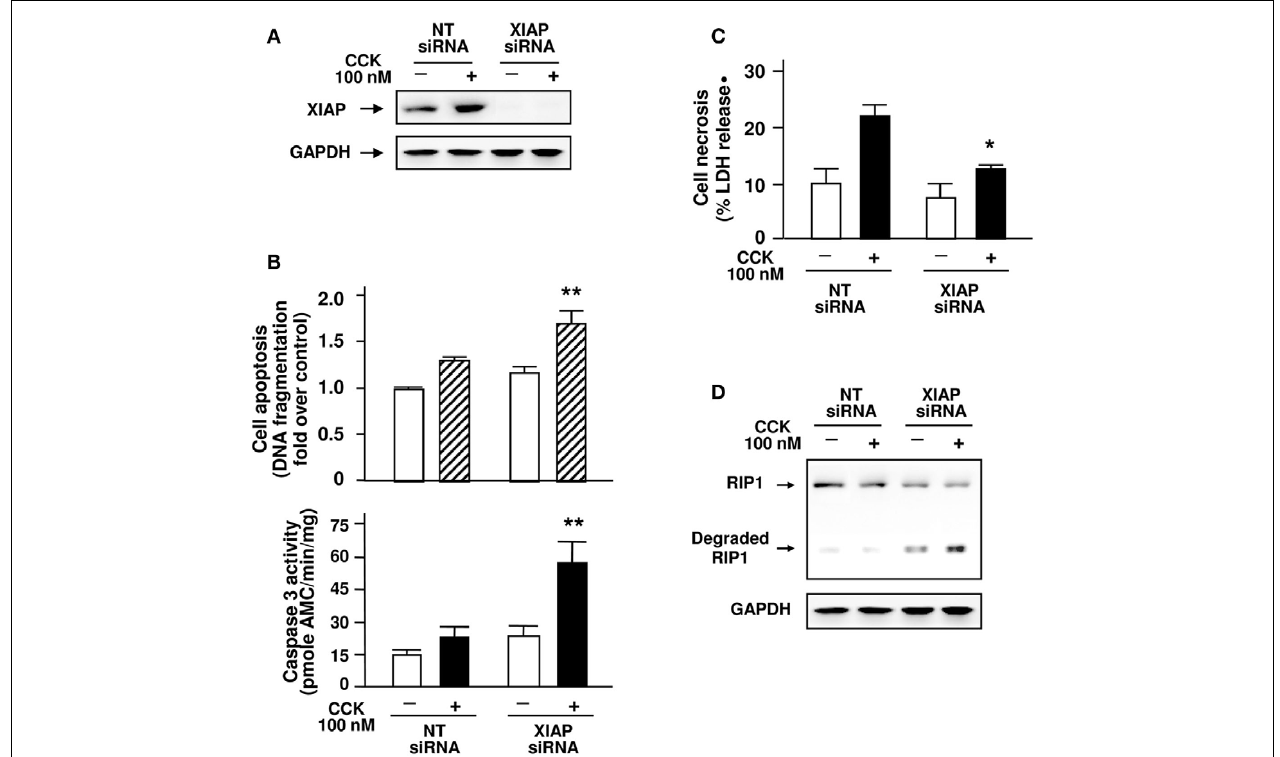
“Experimental Procedures.” Results are expressed as increased fold over control. Caspase activities were measured as described in Section “Experimental Procedures” for the lysates of transfected AR42J cells. (C) Cell necrosis was measured by the percentage of total cellular LDH released into the extracellular medium. Graphs (B,C) show means ± SE ( n = 3 to 4) for each condition. ** P < 0.01 or * P < 0.05 versus each corresponding NTsiRNA control with CCK-treated, as indicated. (D) Western blot analysis of the cell lysates using RIP1 antibody for RIP1 protein level and degradation and using GAPDH antibody to verify equal loading. Shown are representative blots from three independent